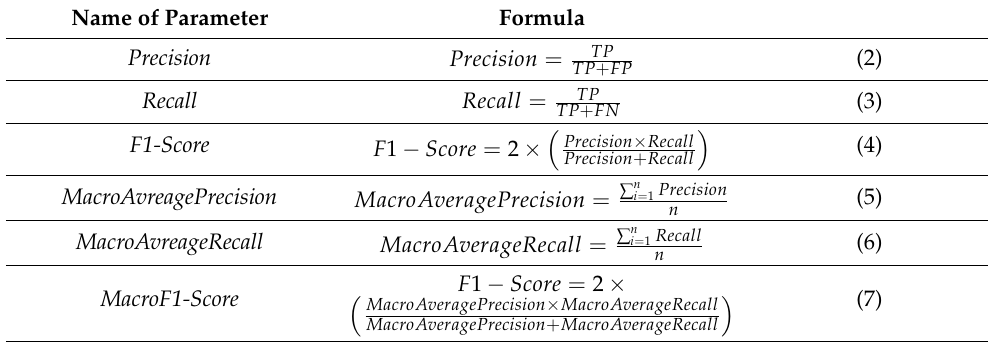
Table 7. The DCNN quality assessing coefficient.